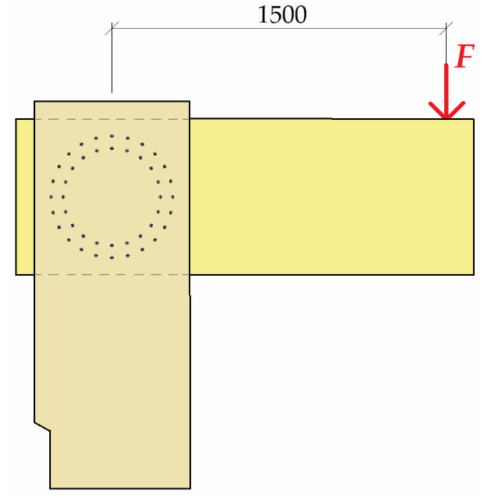
Figure 6. Position of the load F